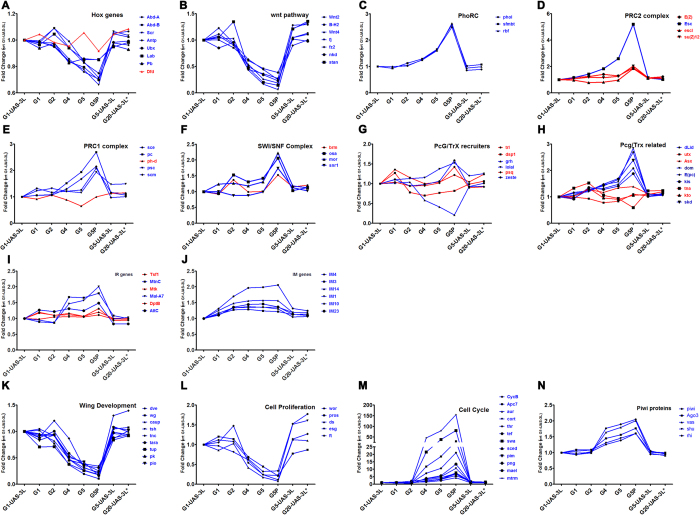
Genes and gene families misregulated across multiple generations in DNMT3L expressing transgenic flies.Graphical representation of gene expression changes (shown as fold change with respect to G1) for the depicted genes across the various generations. Hox gene family (A), wnt pathway genes (B), Polycomb and Trithorax group of proteins (C–H), Immune response (IR) & Immune induced (IM) genes (I,J), genes involved in wing development (K), cell proliferation (L) and cell cycle (M) and piwi group of proteins (N) were analysed. Y-axis shows fold change with respect to gene expression of the specific gene in control G1 UAS-3L (without Tubulin-GAL4 driver) larvae. G1 and G5-UAS-3L are control larvae are without GAL4 driver from G1 and G5 generation respectively. G1 to G5- Tub-3L larvae from the indicated generation. G5P- G5 Tub3L larvae that had melanotic tumors. G20-UAS-3L* denotes larvae from G20 generation after crossing out of the Tubulin-GAL4 driver. The profile of genes that showed change of gene expression are denoted by blue connecting lines and red connecting line is used to depict genes that do not show a consistent change in gene expression across the various generation. The names of genes examined and their symbols are depicted in the legend for each graph.